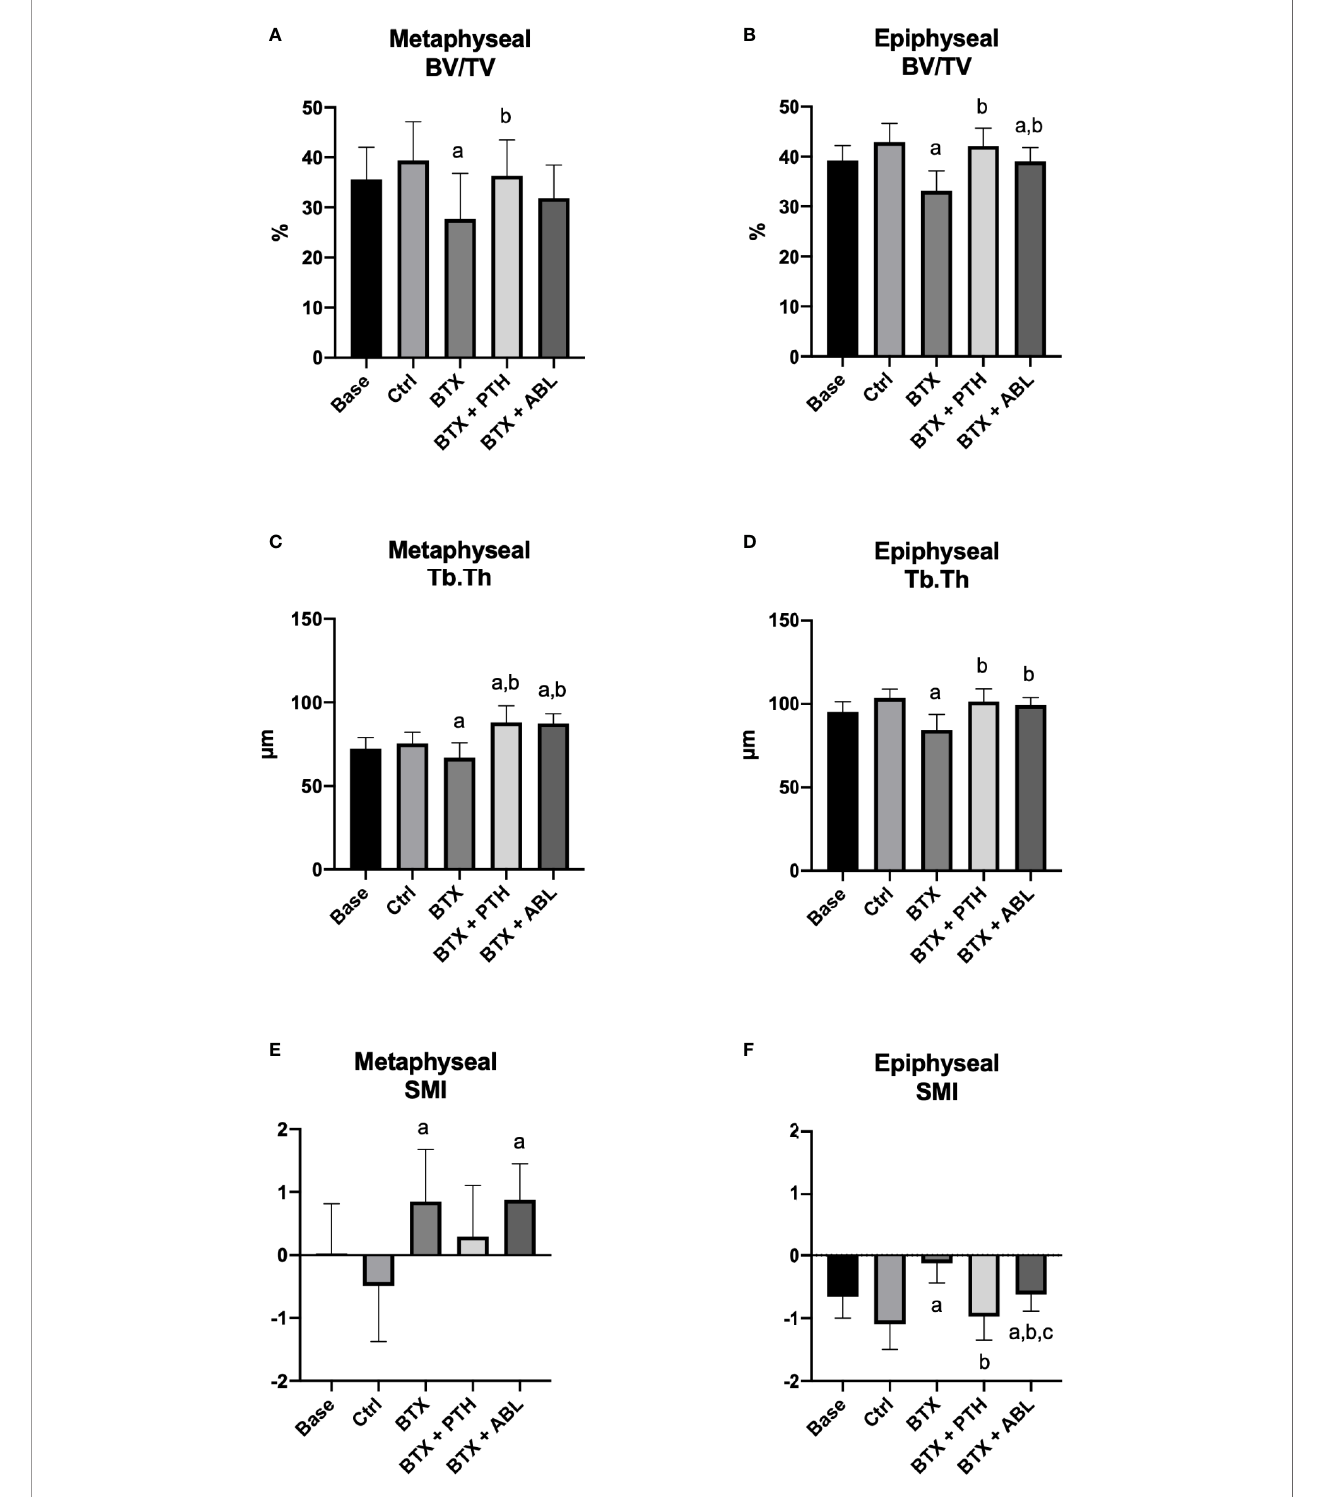
FIGURE 5 | Distal femoral metaphyseal and epiphyseal trabecular bone parameters determined by m CT from rats with the right hindlimb immobilized with BTX and treated with PTH or ABL. (A , B) BV/TV, bone volume/tissue volume; (C , D) Tb.Th, trabecular thickness; (E , F) SMI, structure model index. Data are presented as mean ± SD. a: p < 0.05 vs. Ctrl. b: p < 0.05 vs. BTX. c: p < 0.05 vs. BTX +